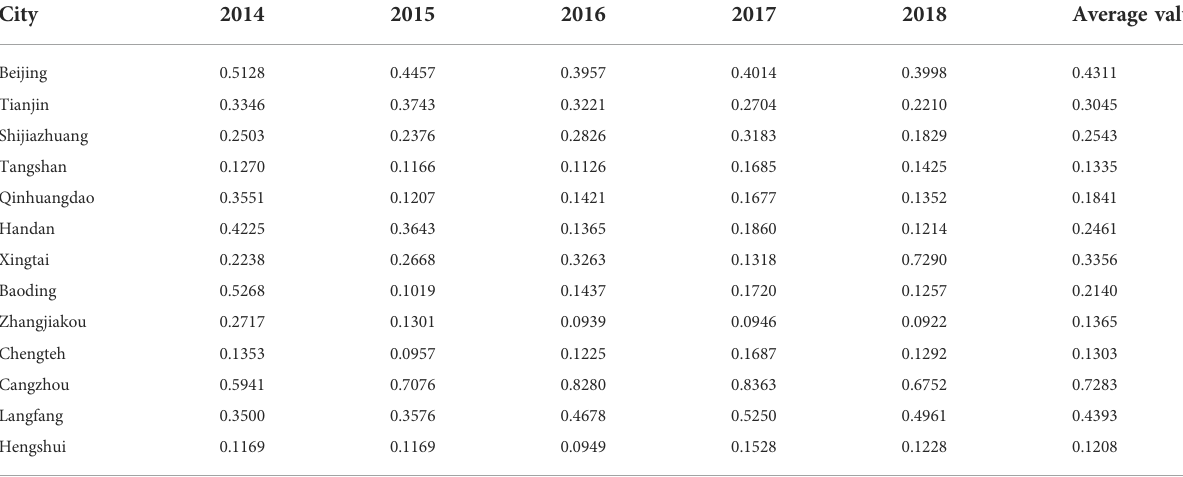
TABLE 2 Comprehensive evaluation results of compactness in the Jingjinji urban agglomeration.